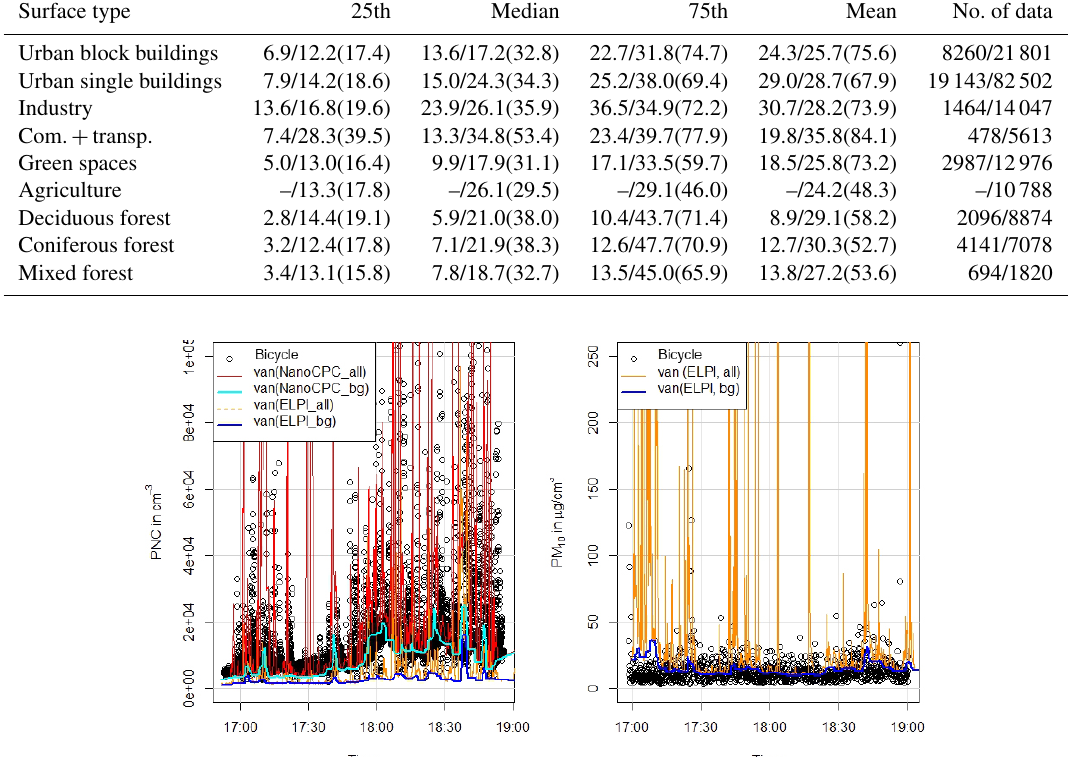
Figure 6. Comparison of bicycle and van-based particle measurements: (left) total particle number concentration and (right) PM 10 mass, on 4 August 2014. Van measurements are shown by the two colored lines, with the red line representing all measurements and the blue line the calculated background concentrations (10th percentile of 3min running mean). The time is provided in CEST.